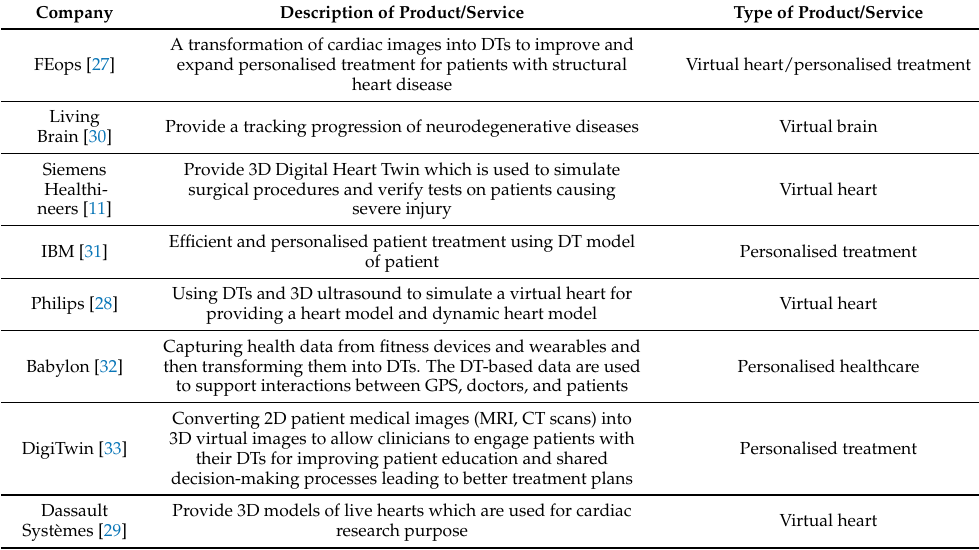
Table 4. The progression in the industry for digital twins in relation to smart personalised healthcare.